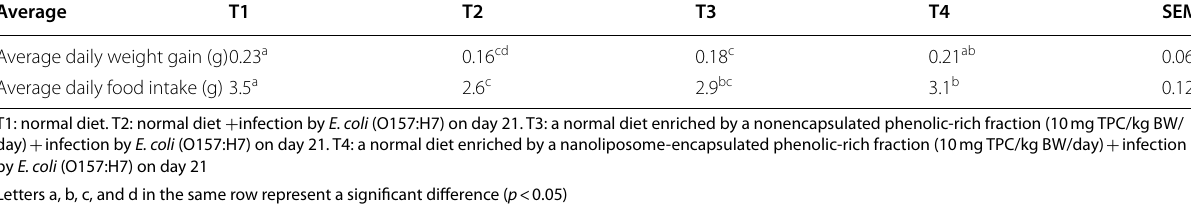
Table 3 The average changes in weight and food intake